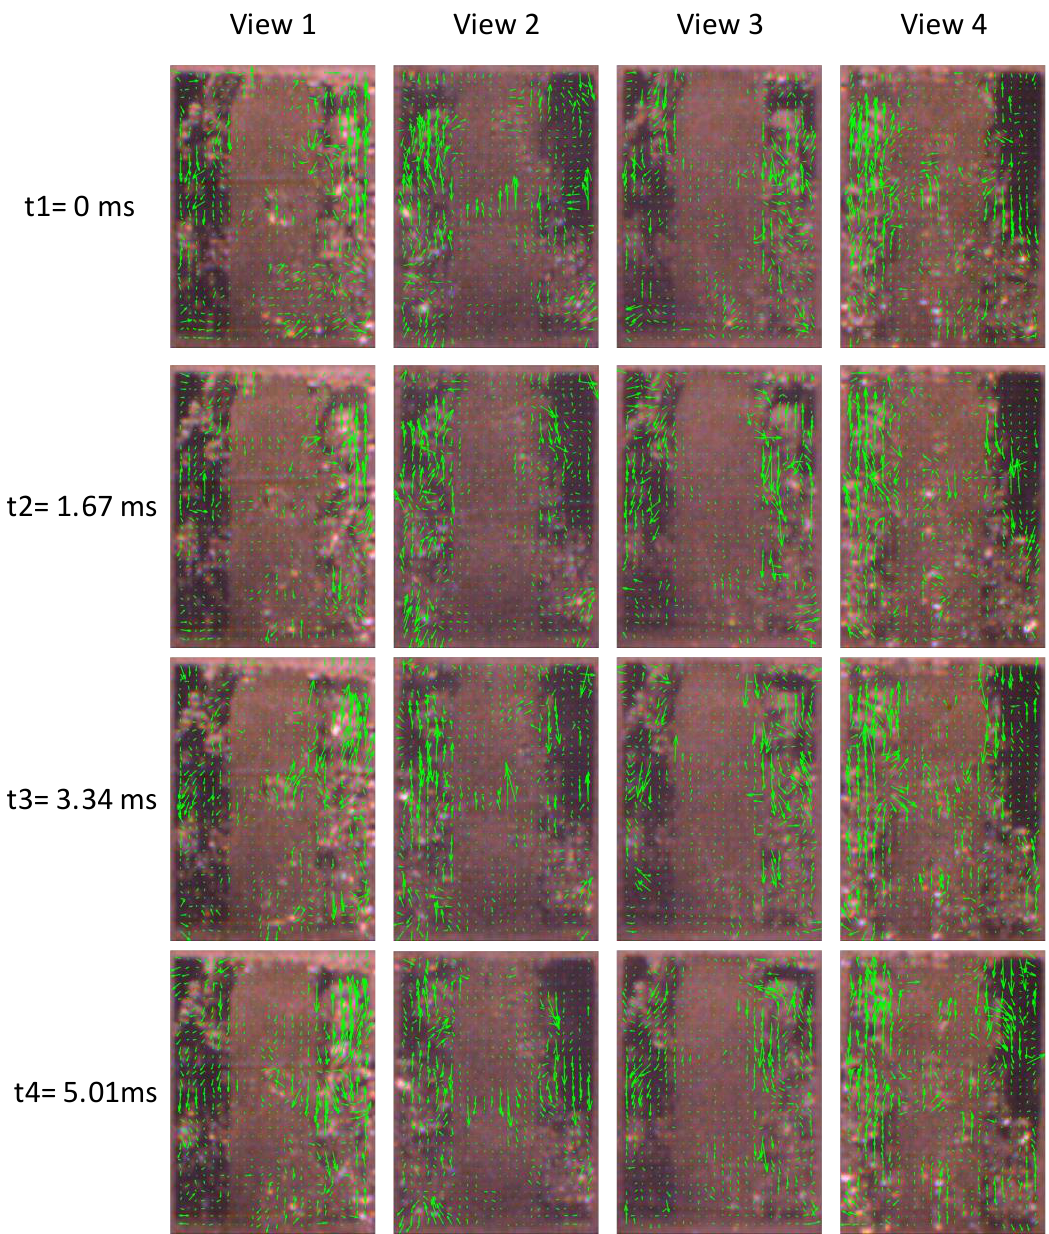
Figure 14. Velocity vector drawings of particle image velocimetry (PIV) results for a short period of